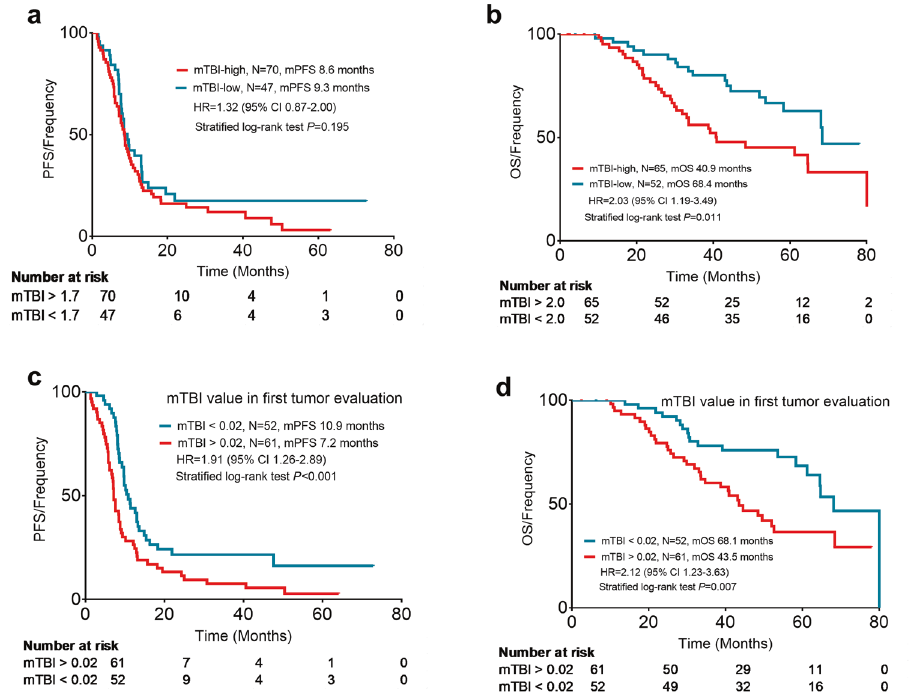
Fig. 2 Survival analysis based on the mTBI at pretreatment and fi rst tumor evaluation. a PFS analysis based on the mTBI at pretreatment. b OS analysis based on the mTBI at pretreatment. c PFS analysis based on the mTBI at the fi rst tumor evaluation. d OS analysis based on the mTBI at the fi rst tumor evaluation. PFS progression-free survival, OS overall survival, HR hazard ratio, CI con fi dence interval, mTBI molecular tumor burden